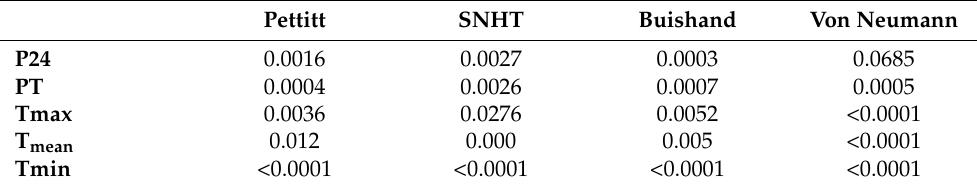
Table 2. Results of the homogeneity tests.